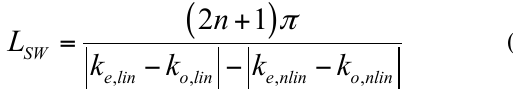
Figure 5: Dispersion curves of (a) the even and (b) the odd modes of the directional coupler for the linear and nonlinear cases.